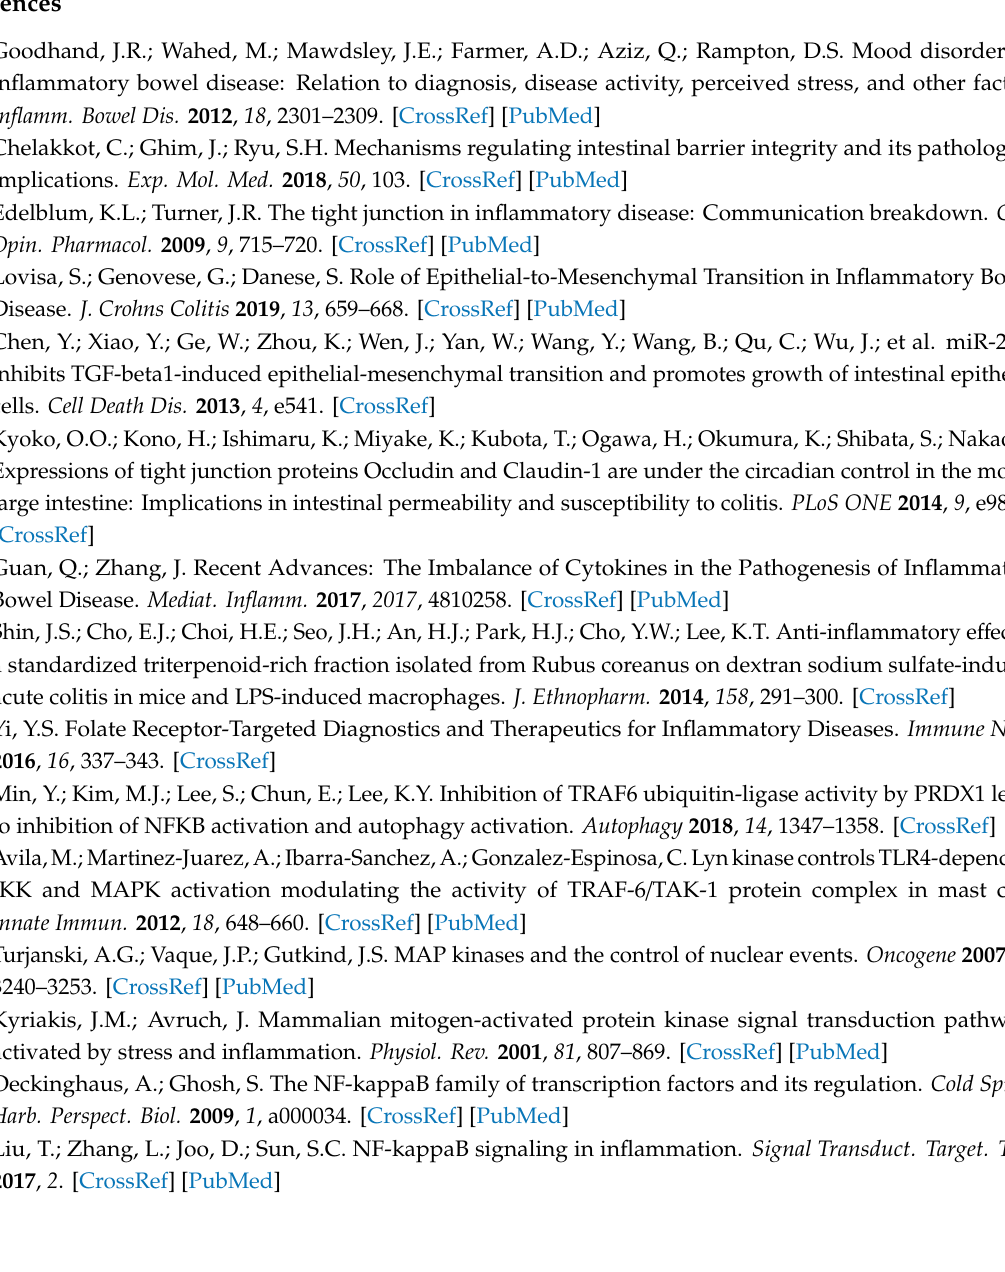
Figure S1: E ff ects of KA on MAPKs in LPS-induced RAW 264.7 macrophages. (A) Cells were pretreated with KA (20, 40, or 80 µ M) for 1 h, and then stimulated with LPS (1 µ g / mL) for 10 min. Total cellular proteins were prepared and resolved by SDS-PAGE, transferred onto PVDF membranes, and detected using specific p-ERK, ERK, p-JNK, JNK, p-p38, and p38 antibodies. β -actin was used as internal control. The experiment was repeated three times, and similar results were obtained. Table S1: List of